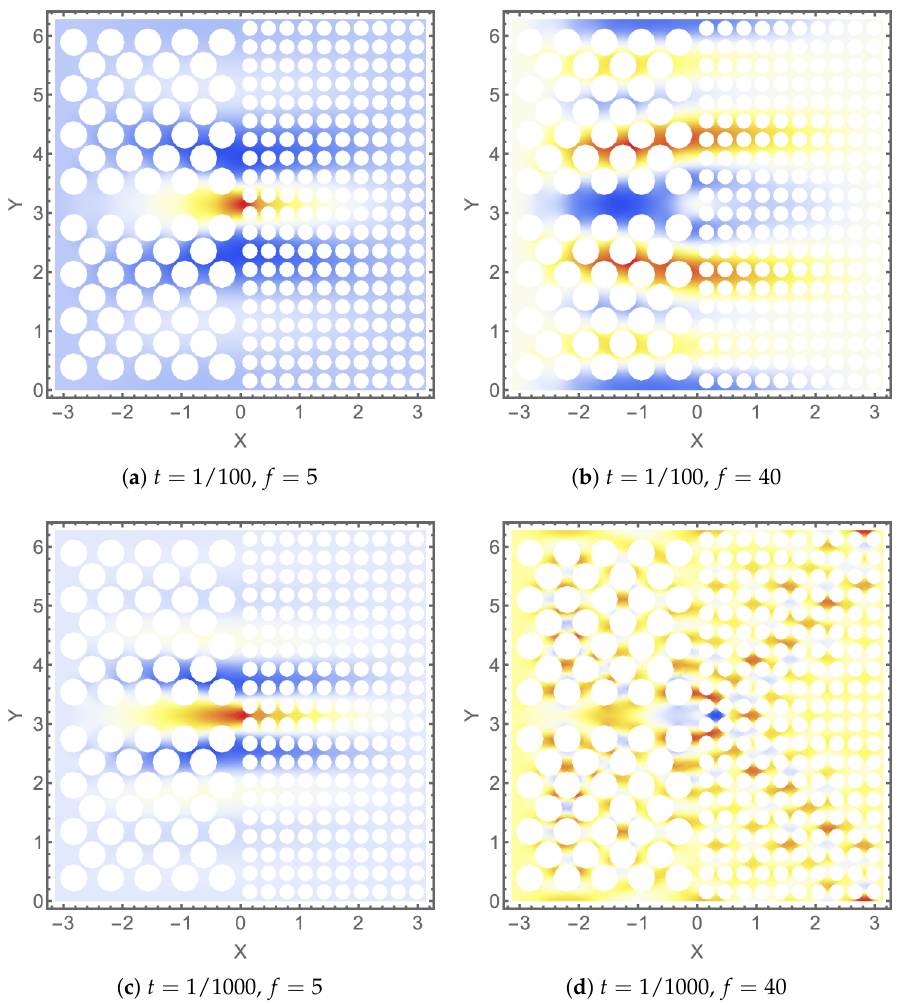
Figure 4. Concentrated load. Relative transverse displacement field with temperature colours. Observed energies: ( a ) 2.66805, ( b ) 8.45301 ( c ) 145.964, ( d )